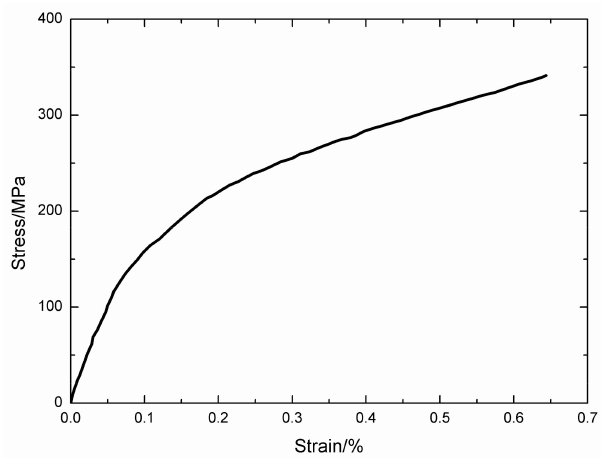
Figure 2. Tensile curve of 2.5D woven self-healing Hi-Nicalon TM SiC / [Si-B-C] composite at 600 ◦ C in an air atmosphere.